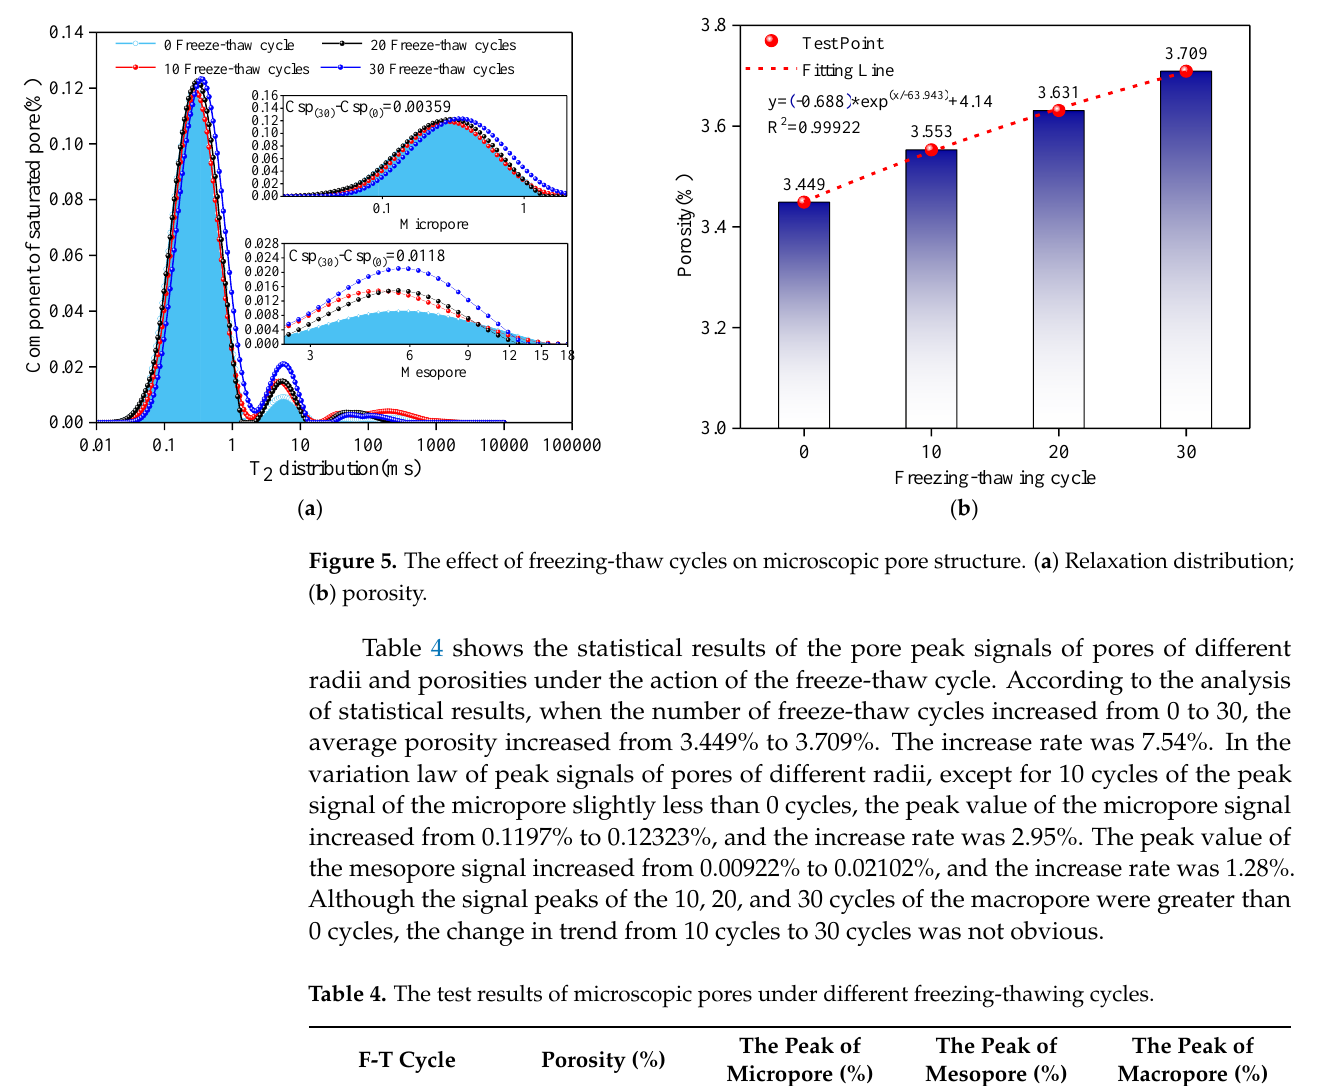
The Peak of Micropore (%)